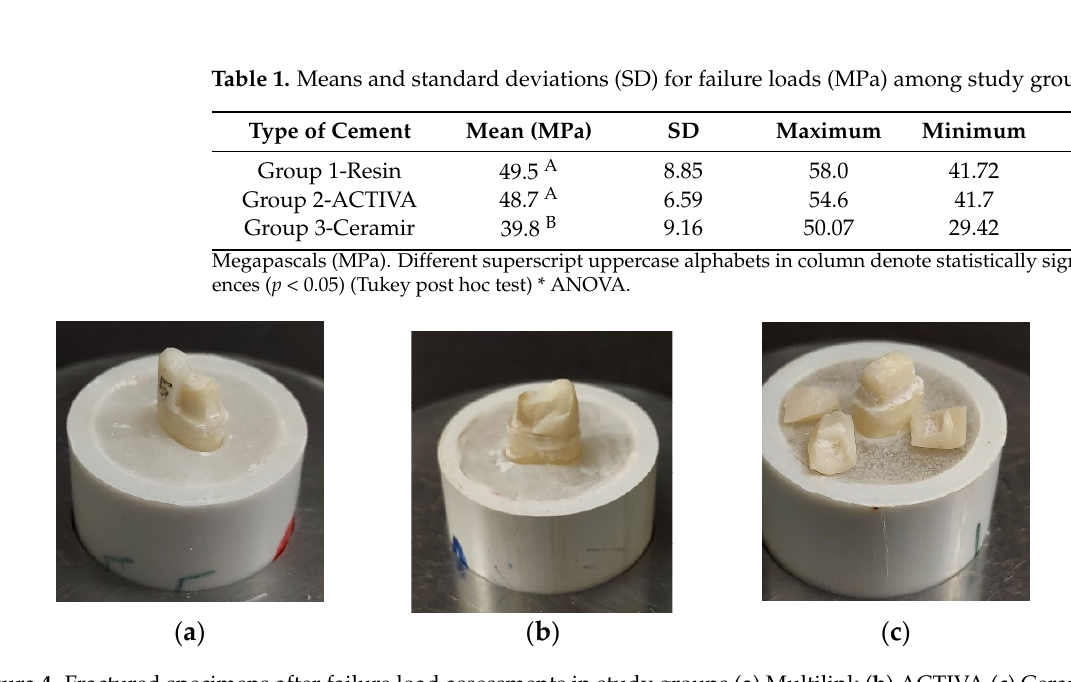
Figure 4. Fractured specimens after failure load assessments in study groups ( a ) Multilink ( b ) ACTIVA ( c ) Ceramir. Crown fractures are related to the amount of microleakage. Table 2 presents means and standard deviations for microleakage among different cement groups. The highest amount of microleakage was observed in Group C-Ceramir (2.563 ± 0.71) compared to